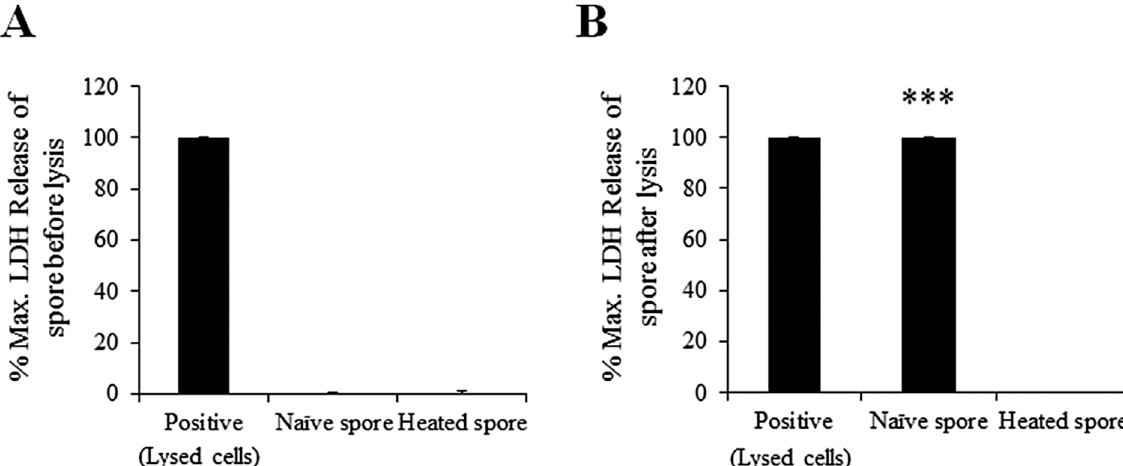
Figure 2. Cytotoxicity in naïve and heated spores of Kudoa septempunctata . Lactate dehydrogenase (LDH) release was measured before and after lysis. Data are presented as mean ± standard error (SE) of three independent experiments performed in triplicate. *** p < 0.001 vs. naïve spores before lysis.